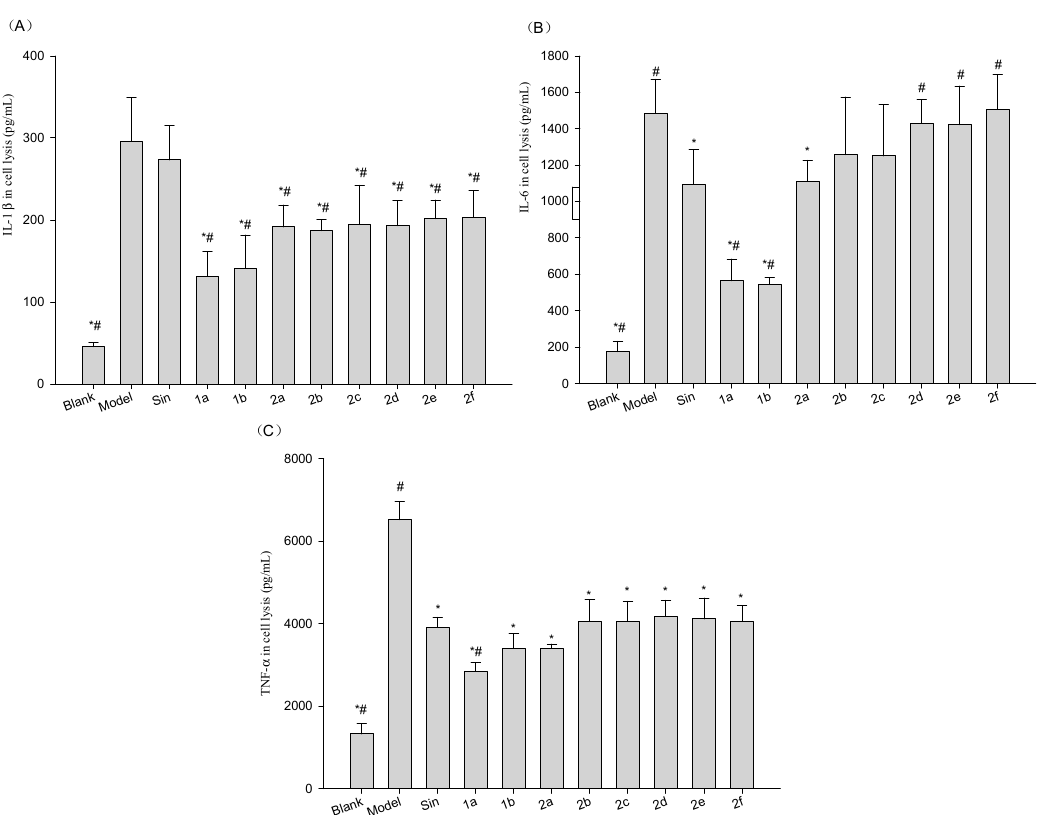
Figure 5 . Effect of Sin and 1a – 2f on ( A ) IL1 β ; ( B ) IL6; and ( C ) TNF- α expression in LPS-treated Raw264.7 cells. Raw264.7 cells were treated with 1 µg/mL of LPS (Blank was untreated), followed by 10 µ g/mL Sin or 1a – 2f for a total of 12 h. The blank and vehicle (Model) samples were treated with an equivalent volume of vehicle. Sin reduced the LPS induced increase in IL6, or TNF- α , while the 1a – 2f derivatives significantly reduced all inflammatory cytokines to varying degrees. Results are expressed as mean ± SD ( n = 3). * p < 0.05 vs. vehicle (Model); # p < 0.05 vs. Sin.